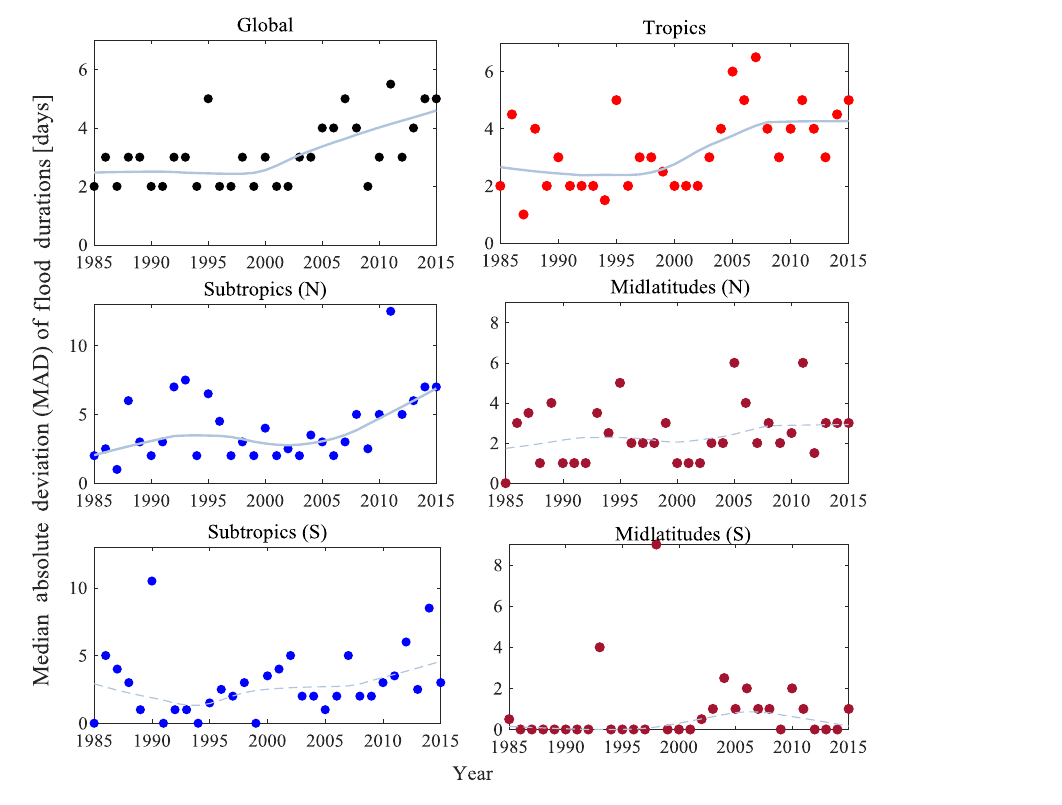
Figure 4. Same as Fig. 2 but for median absolute deviation (MAD) of flood durations.